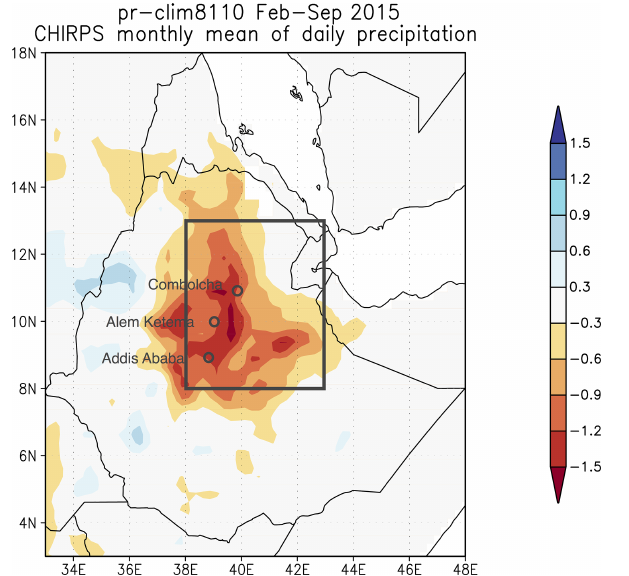
Figure 1. Event definition of the drought event in February– September 2015 in Ethiopia; the box shows the spatial extent of the event definition and the circles show the three station loca- tions. Colours show the anomaly in precipitation (CHIRPS, pre- cipitation minus 1981–2010 climatology) averaged over February– September 2015 (mmd − 1 ). See Philip et al. (2018c) for more de-